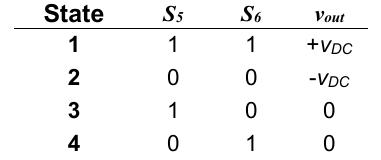
Table 1. Operation states of the dc-dc converter.